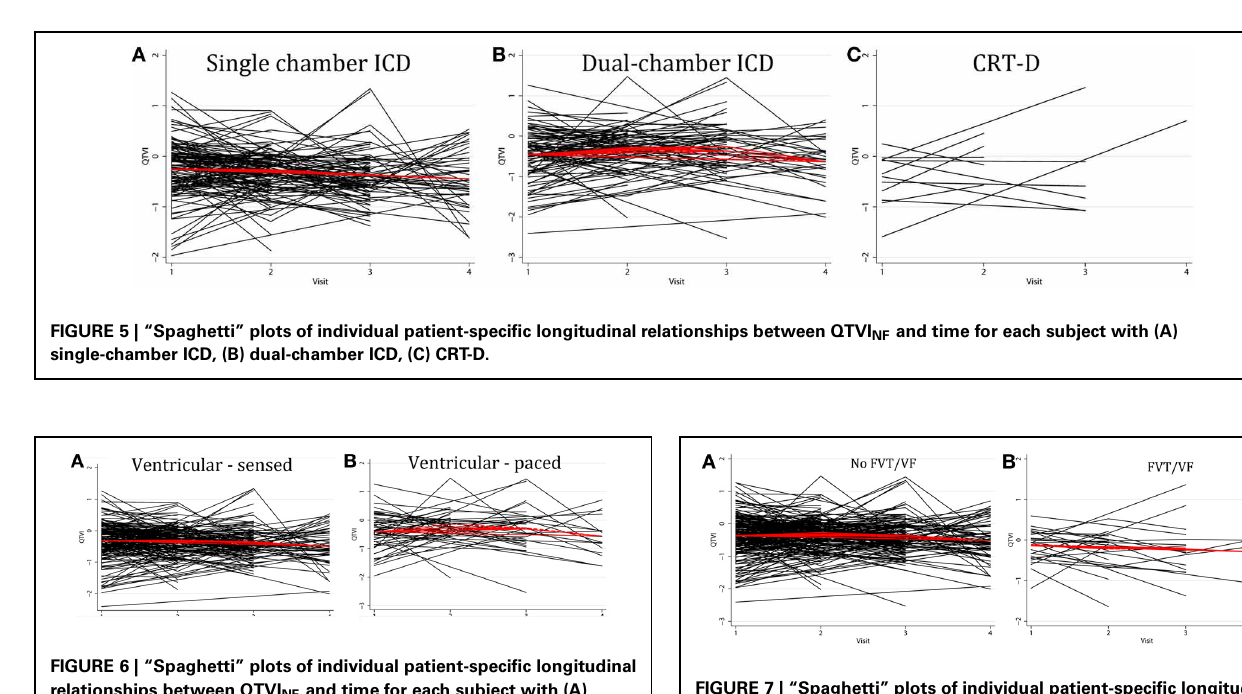
FIGURE 7 | “Spaghetti” plots of individual patient-specific longitudinal relationships between QTVI NF and time for each subject (A) without FVT/VF, and (B) with sustained FVT/VF and appropriate ICD